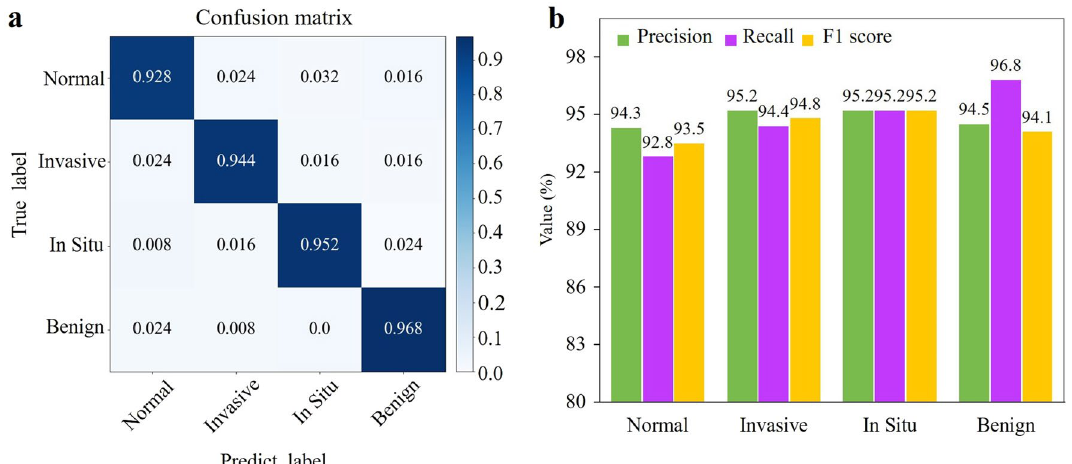
Figure 7. Results of the whole network on the BACH test dataset. ( a ) Confusion matrix illustrating the classification done by MSMV-PFENet. ( b ) Histogram of the precision, recall and F1 score for the evaluation of